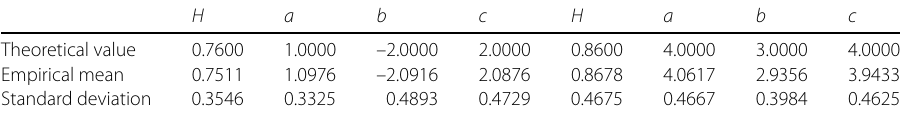
Table 2 The means and standard deviations of the estimators with N = 900